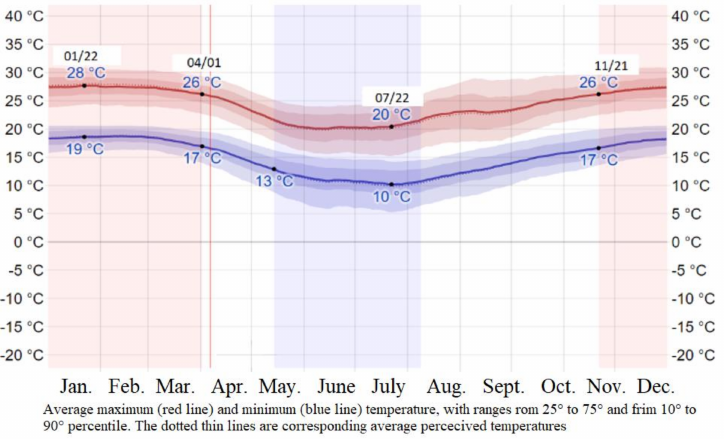
Figure 1. Maximum and minimum temperature